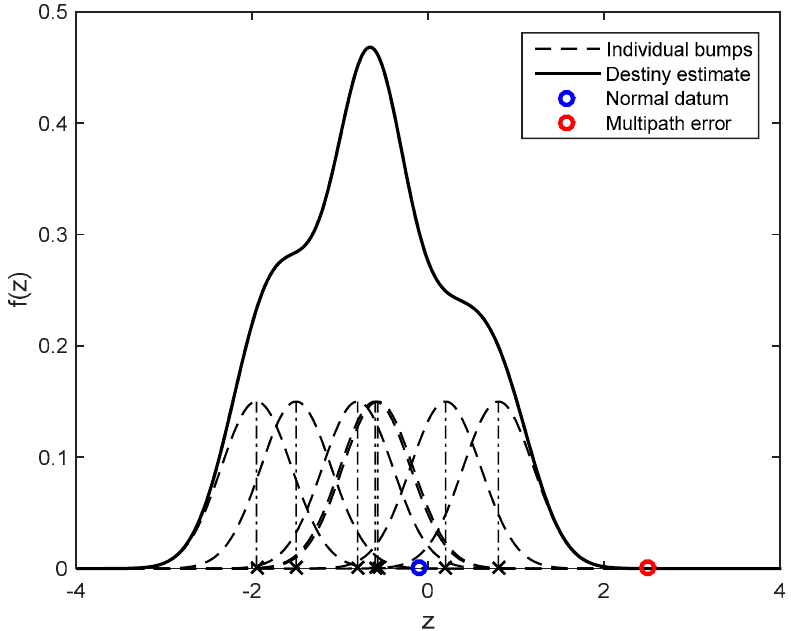
Figure 1. Kernel density estimates showing individual Gaussian kernels and credibility detection.